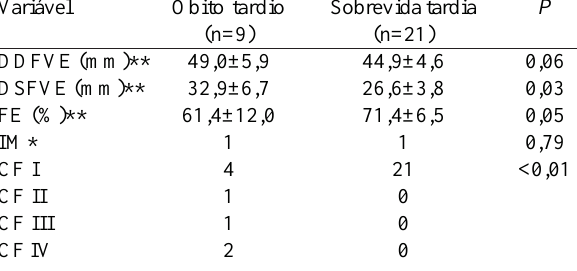
Tabela 4. Classe funcional e variáveis